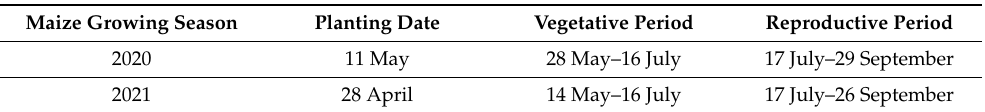
Table 2. The planting date, the observed vegetative and reproductive growth stage dates for maize during the 2020 and 2021 growing